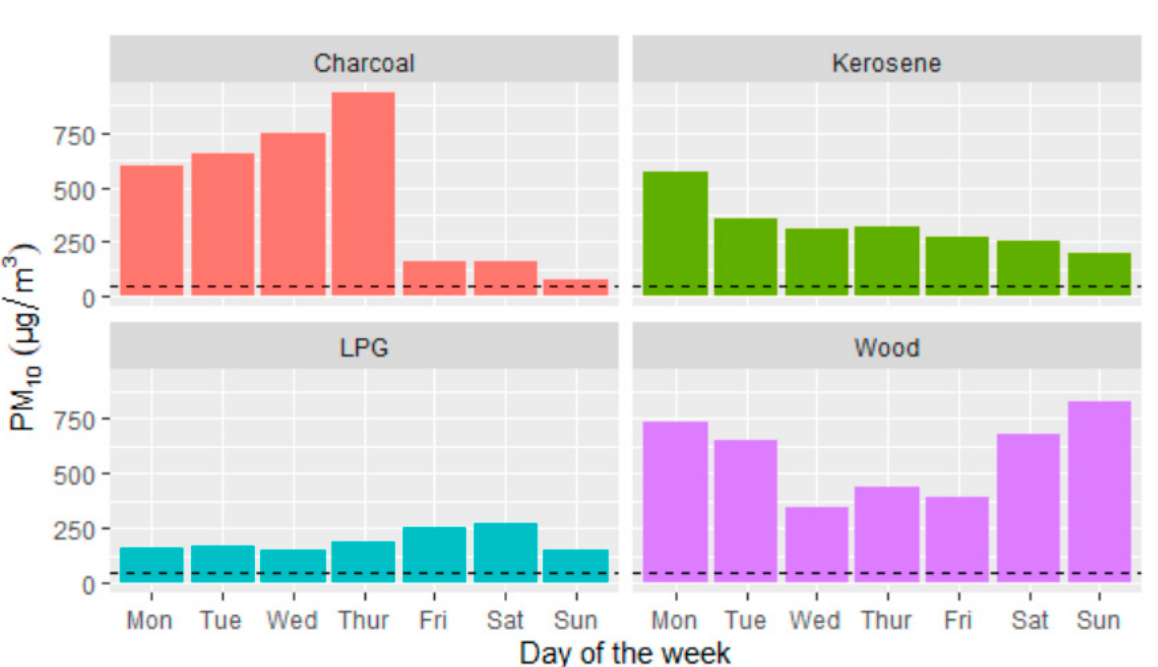
Figure 6. Graph showing daily variation of PM 10 by fuel type. Dotted line plotted at 45 µg/m 3 , which is the mean 24 h WHO limit.